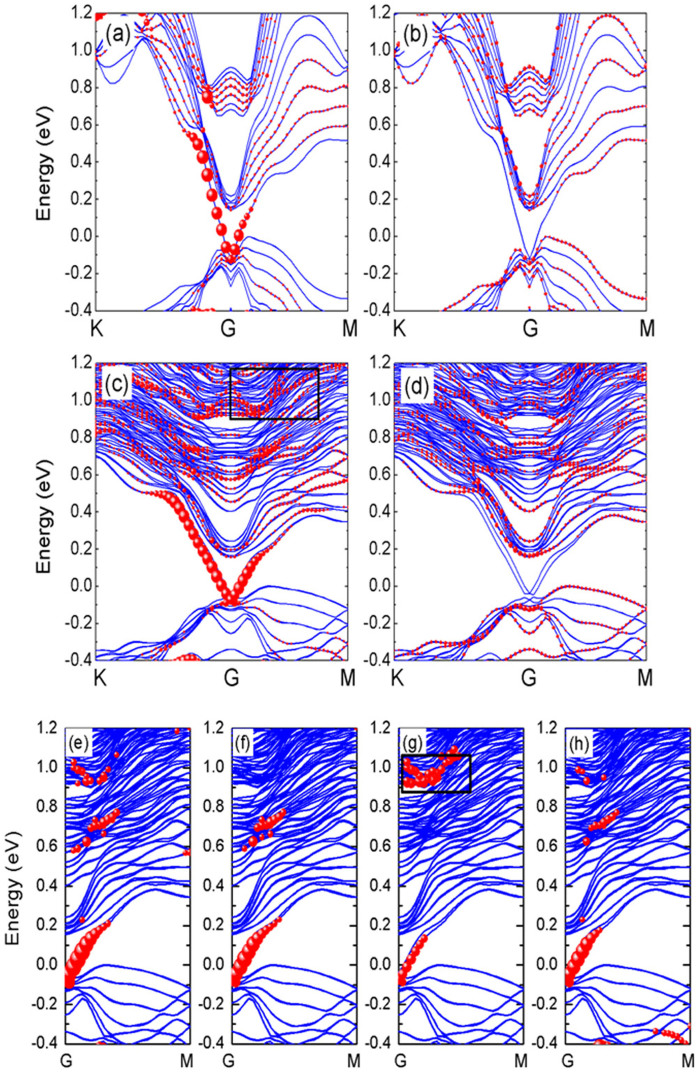
The calculated electronic structures of (Bi1−xSbx)2Te3.(a), (b) Projected band structures of surface layer and bulk layer of pure Bi2Te3, respectively. (c), (d) Projected band structures of surface layer and bulk layer of BiSbTe3, respectively. (e) Total bands of BiSbTe3 surface layer, and the decomposed bands projected on (f) Bi, (g) Sb, and (h) Te atoms. The size of red balls corresponds to band weight, and small-size balls with tiny contributions are omitted. In other words, the size of balls indicates the intensity of states.